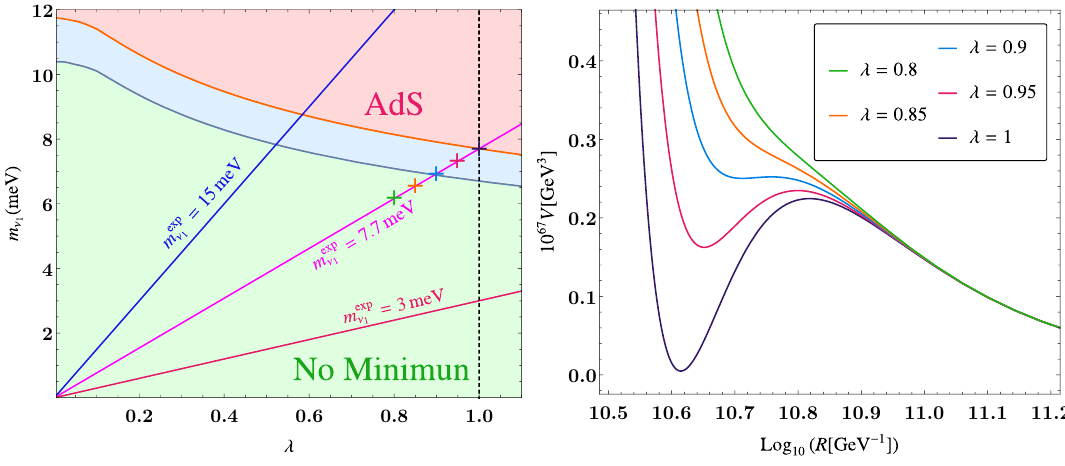
Figure 3 . Left: lightest neutrino mass versus the scanning parameter λ for Dirac neutrinos. The green area corresponds to runaway dS vacua and the pink one to AdS vacua, with a narrow region of dS vacua in between. Straight lines correspond to homogeneous scans for different physical neutrino masses. The lines do not cross from the AdS to the runaway area as long as the lightest neutrino mass is m exp ≤ 7 . 7 meV. Right: in this figure we show how the potential changes along the scanning ν for the particular value m exp = 7 . 7 meV. Coloured crosses in the left hand side correspond to the ν coloured curves in the plot on the right hand